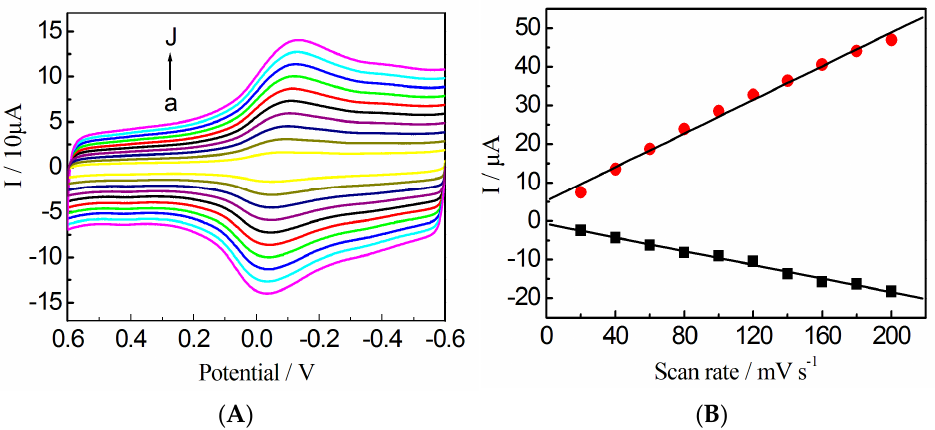
Figure 5. ( A ) CVs of RIF at the MWCNTs-CeO 2 nanorods/GCE at the different scan rates in 0.1 mol/L PBS (a—0.02 V/s, b—0.04 V/s, c—0.06 V/s, d—0.08 V/s, e—0.10 V/s, f—0.12 V/s, g—0.14 V/s, h—0.16 V/s, i—0.18 V/s, j—0.20 V/s). ( B ) The relationship between the redox peak currents and scan rate.